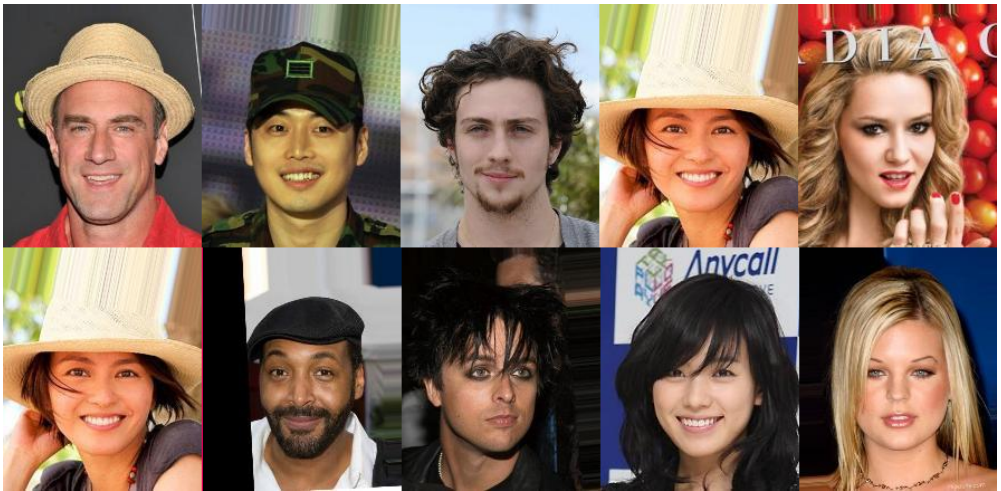
Figure 1. Several random pictures from the CelebA dataset, which was used in this research. The images were aligned and cropped such that eyes of each person are approximately in the same position. The faces were also rescaled, such that they have similar size.